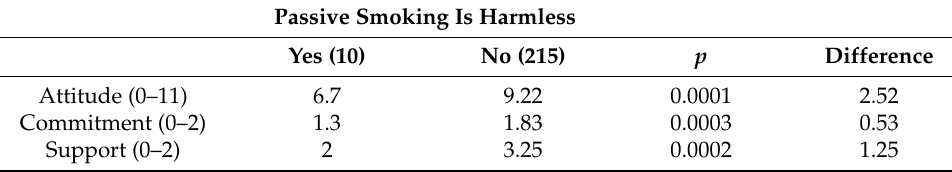
Table 4. Attitudes, commitment, and